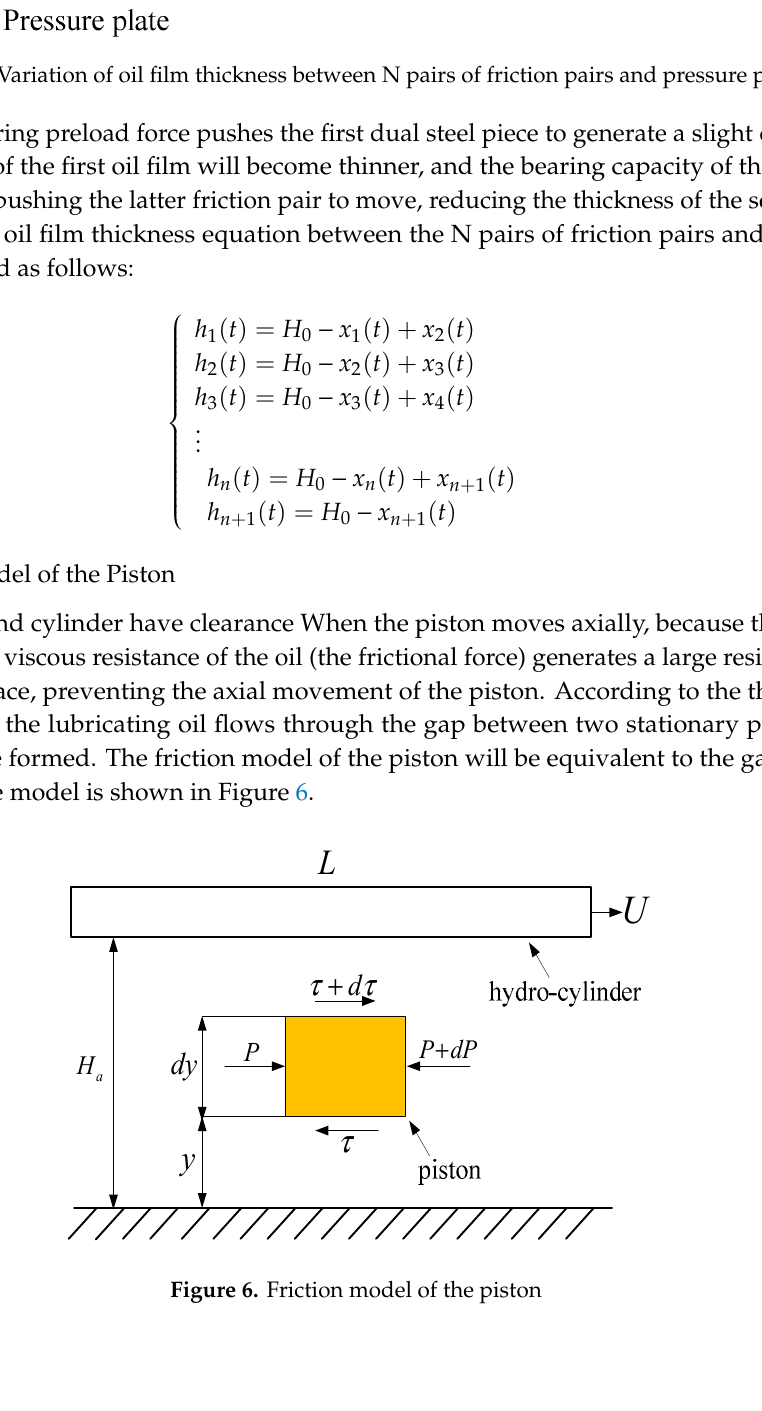
Figure 6. Friction model of the piston